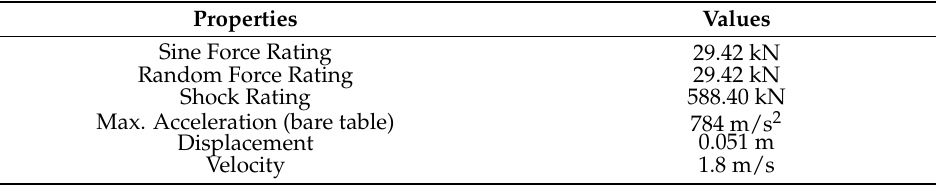
Table 8. Specifications of vibration shaker.